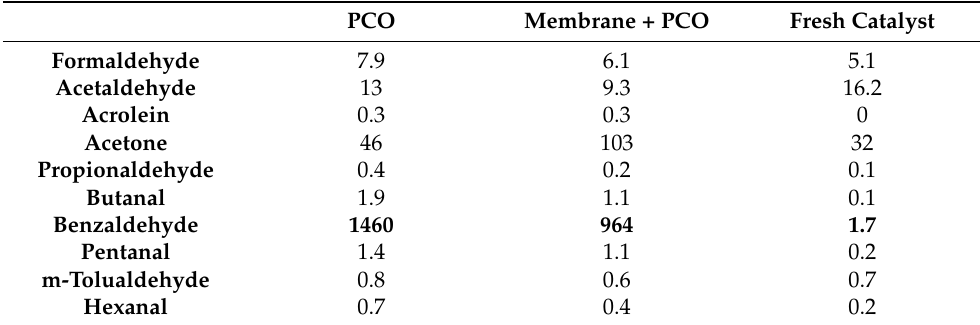
Table 3. Mass concentrations of the main aldehydes and ketones identified on the photocatalytic media ( µ